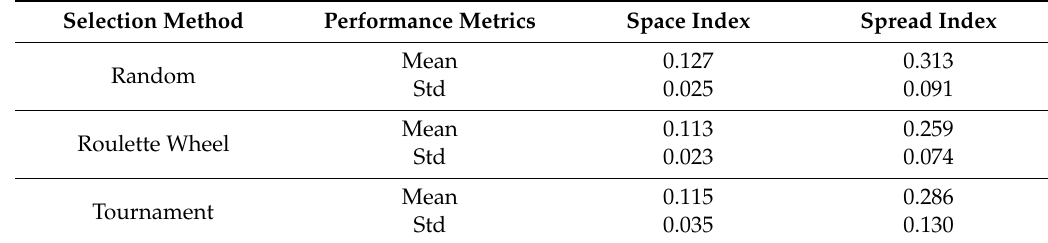
Table 6. Performance comparison of three selection methods in terms of distribution and spread.